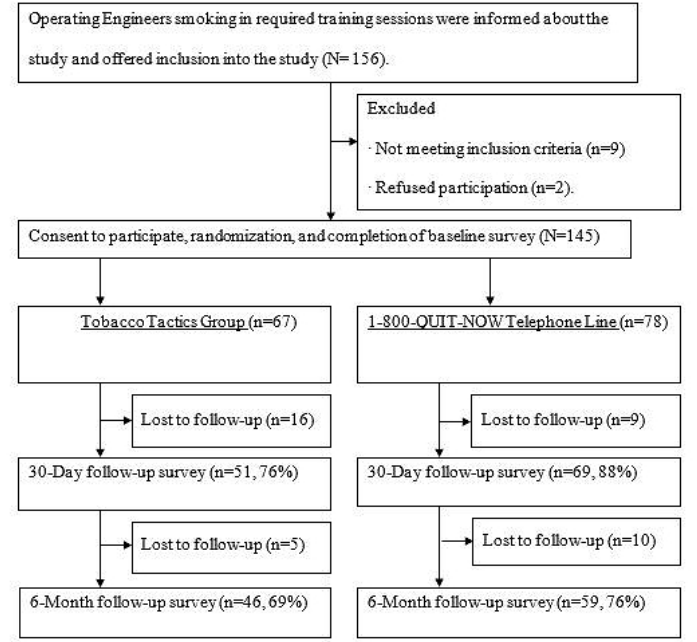
Figure 3. CONSORT